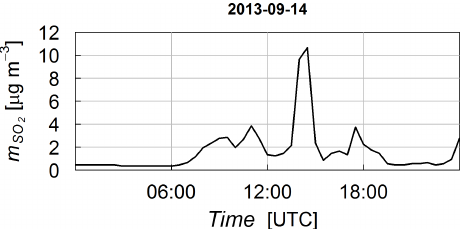
Figure 11. SO 2 mass concentration measured at Melpitz observa- tory on 14 September